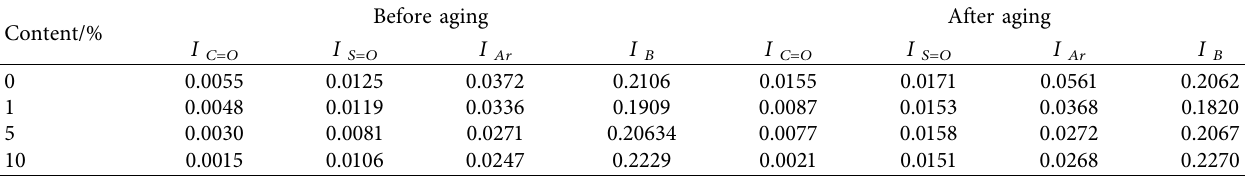
Table 6: Effect of Irganox 1010 on the functional group index of 1#.